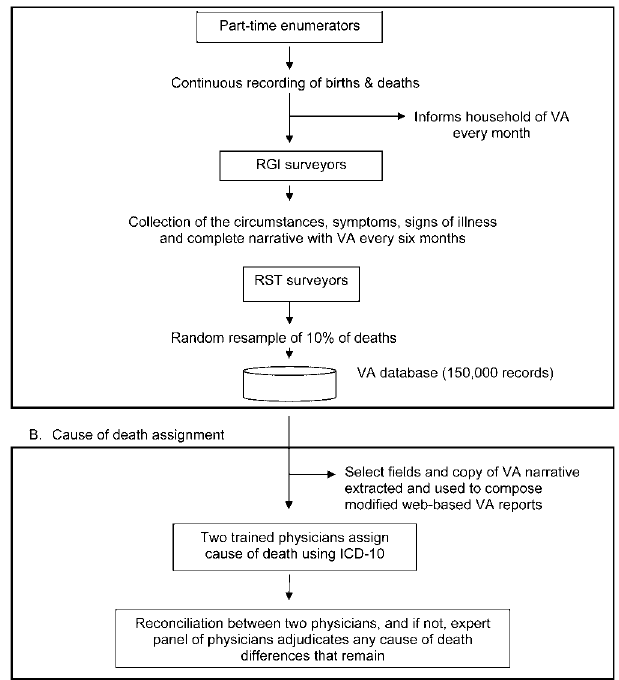
Figure 1. SRS VA Activities DOI: 10.1371/journal.pmed.0030018.g001